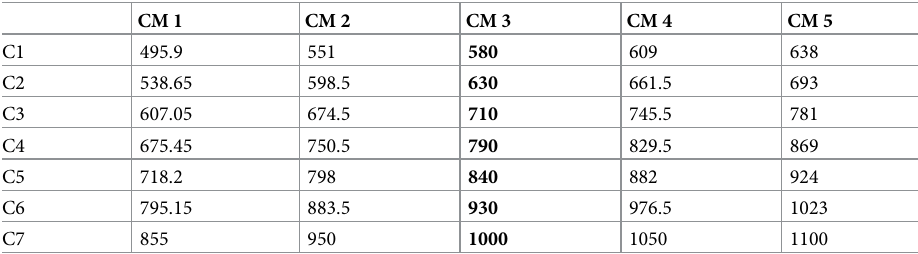
Table 8. Variable CM used under sensitivity–case